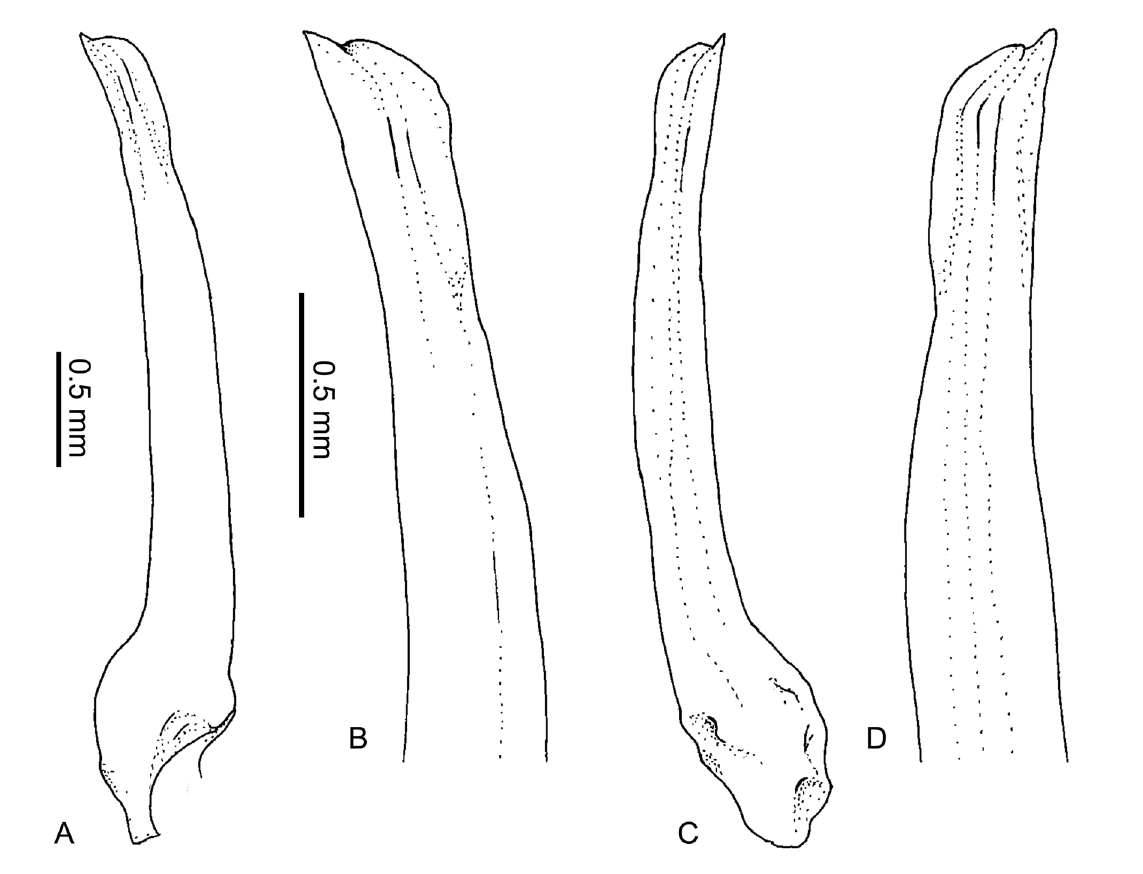
Fig. 15. Stegopleurodon pteridion sp. nov., holotype, ♂ (13.1 × 7.9 mm) (NTOU), South China Sea, drawing of left G1. A . Ventral view. B . Ventral view of distal portion. C . Dorsal view. D . Dorsal view of distal